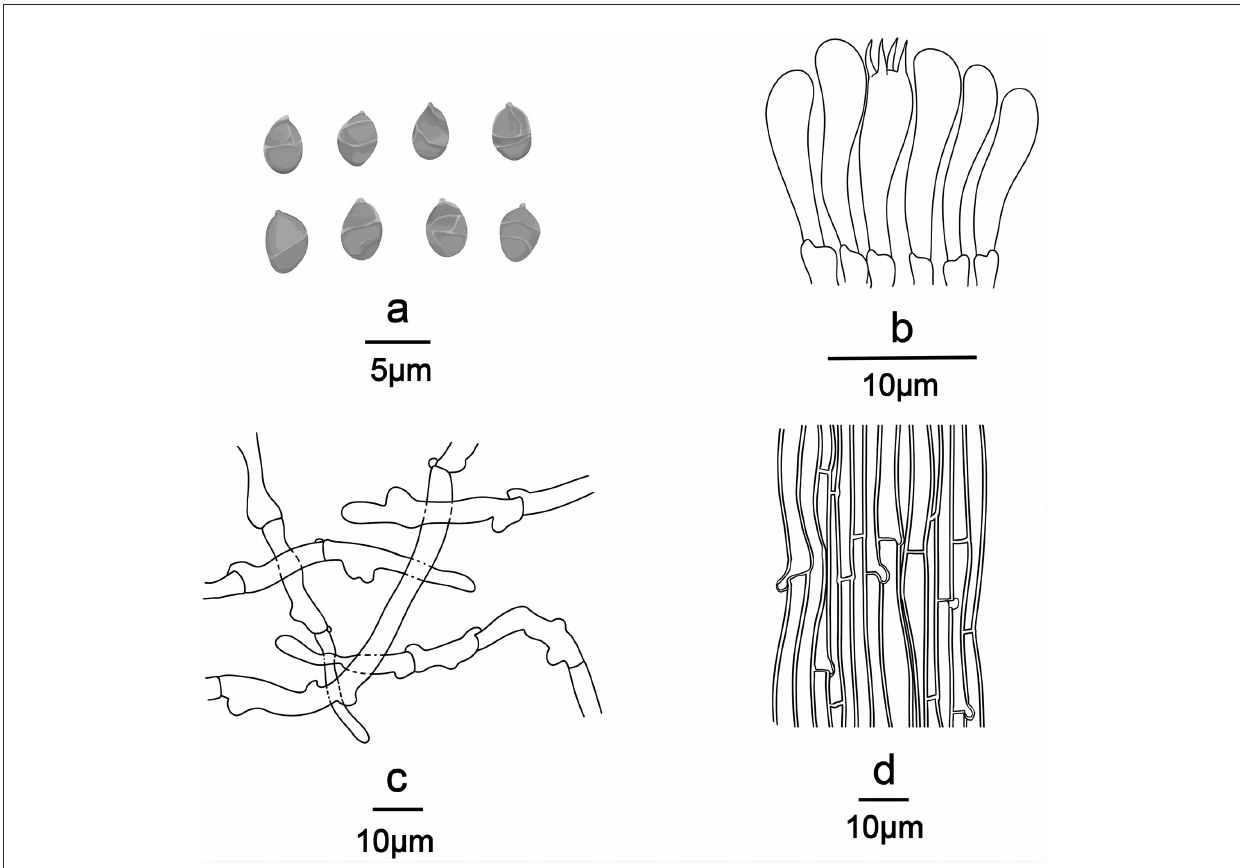
FIGURE7 Line drawings of Ossicaulis borealis (Holotype, SYAU-FUNGI-076). (a) Basidiospores, (b) basidia and basidioles, (c) Pileipellis, and (d) hyphae from trama.